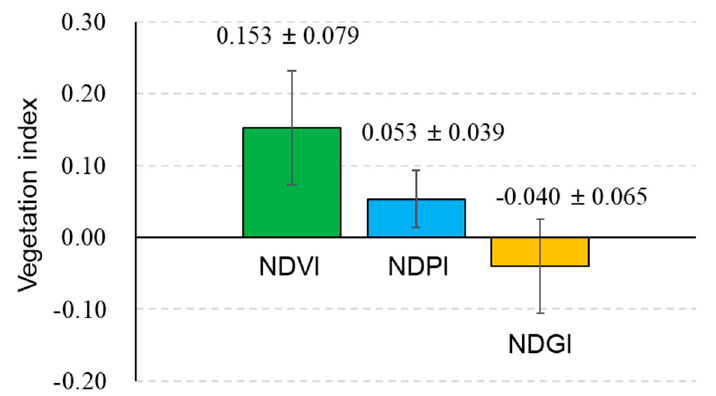
Figure 12. The mean value and the standard deviation of the three vegetation indices (NDVI, NDPI, and NDGI) for the 4438 soil spectra from the Soil Information System (ISIS) of the International Soil Reference and Information Centre (ISRIC).